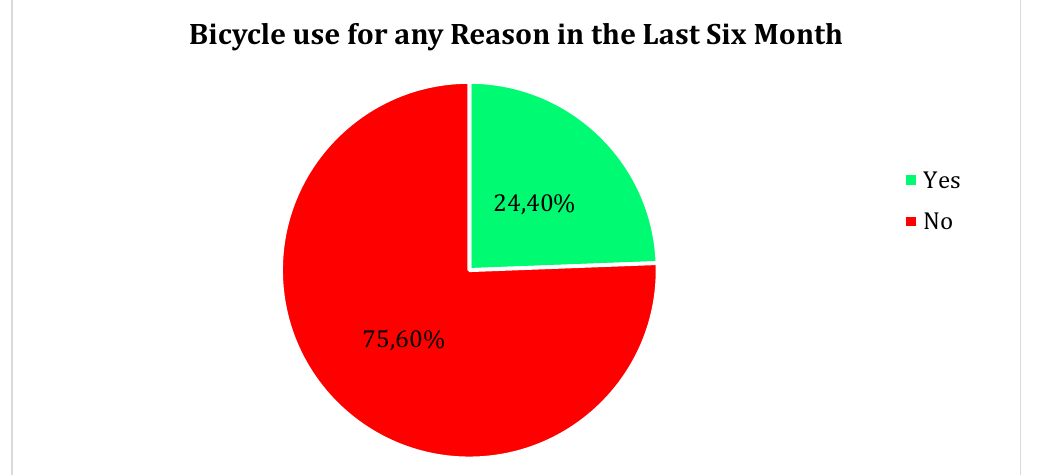
Awareness level of bicycle infrastructure